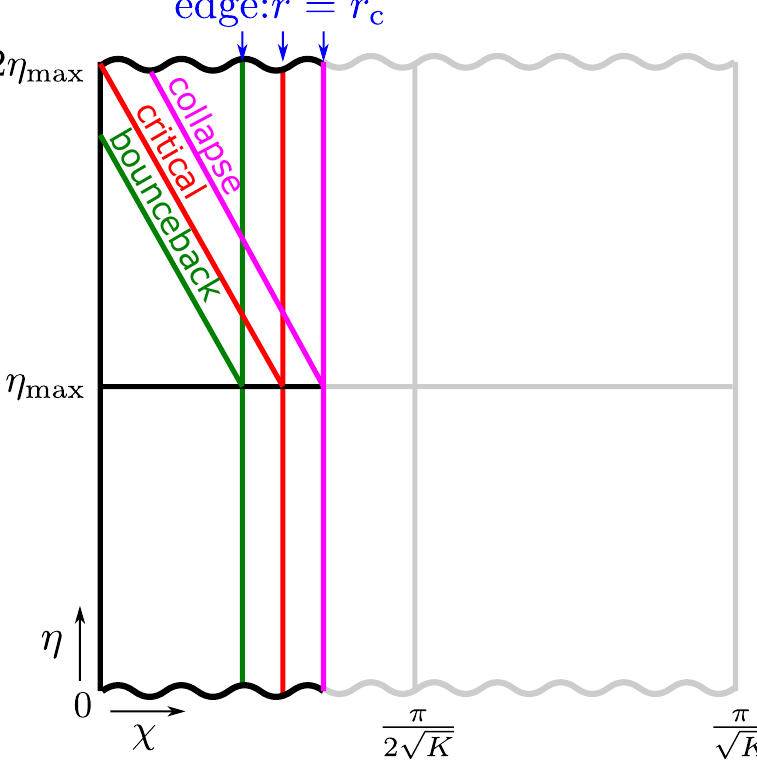
Figure 3. Spacetime diagram for the closed universe with w = 1/3 describing the overdense region and the trajectory of the sound wave propagation from the edge to the center emanated at the time of the maximum